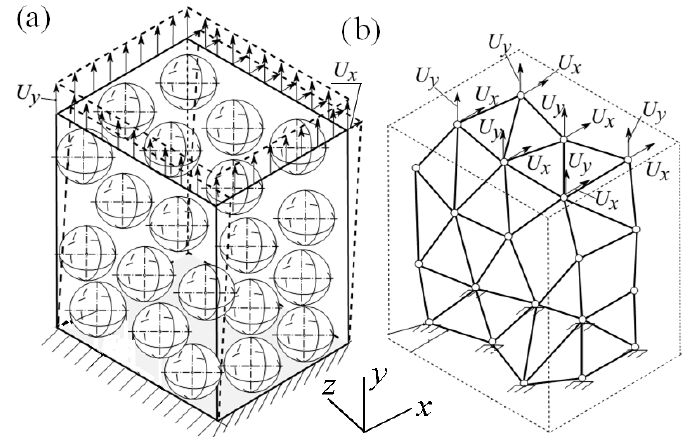
Figure 7. Tensile and shear displacements applied to the samples: 3D FE model of the cube ( a ) and a visualization of the spring model ( b ).